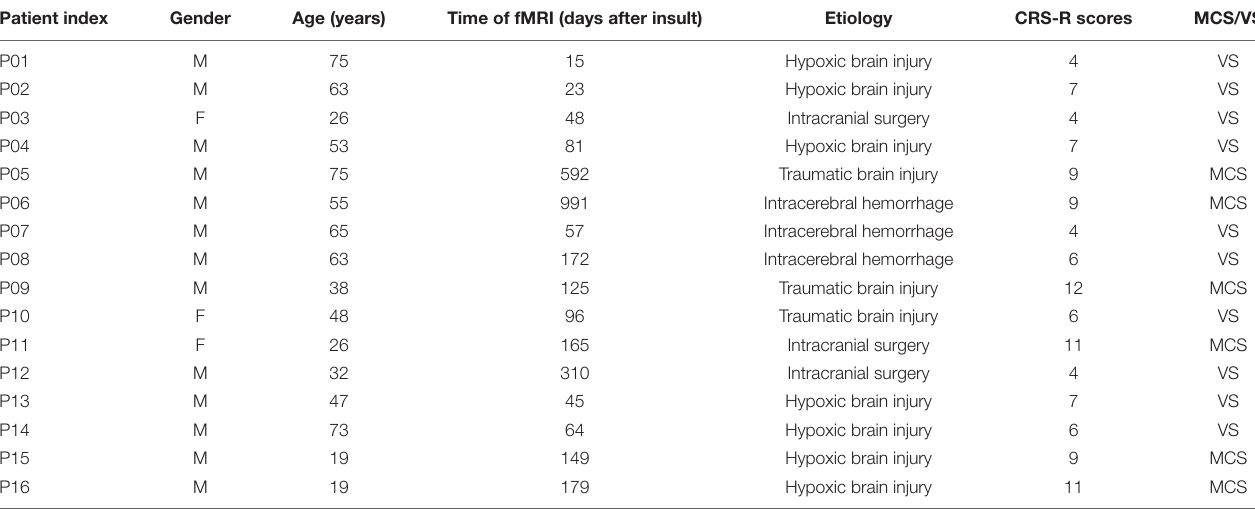
TABLE 1 | Demographic characteristics of the patients with disorders of consciousness (DOC) and the healthy controls (HC). Patient index Gender Age (years) Time of fMRI (days after